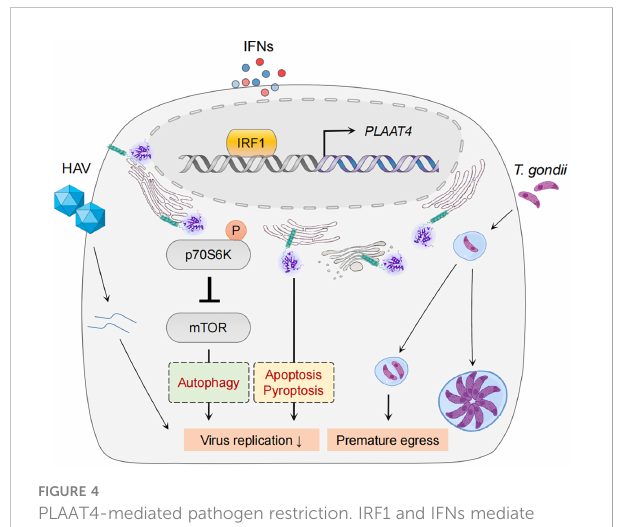
FIGURE 4 PLAAT4-mediated pathogen restriction. IRF1 and IFNs mediate expression of PLAAT4, which acts through in part by inactivating the mTOR signaling pathway to restrict hepatitis A virus replication (left), and induces premature egress to combat Toxoplasma gondii infection (right). PLAAT4-dependent resistance to viral replication might involve autophagy, pyroptosis and apoptosis (shown in dashed